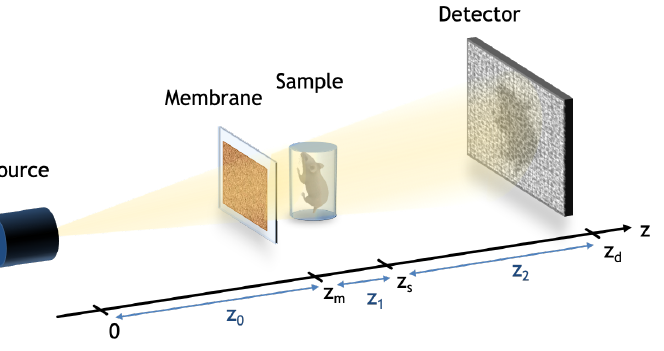
Figure 10. Modulation-based imaging set-up. The beam is modulated by a randomly structured membrane before reaching the sample. Then it propagates to the detector distorted by the membrane and the sample. Several images can be acquired with various positions of the